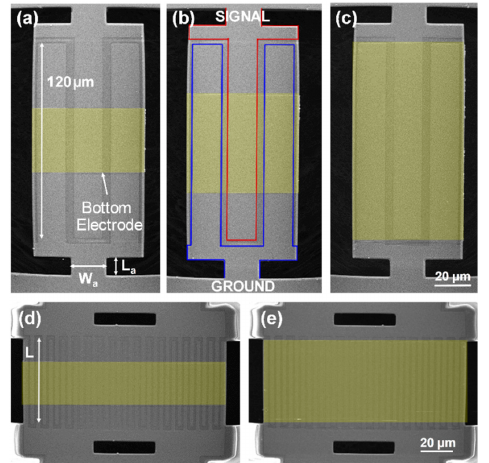
Figure 2. Scanning electron microscope (SEM) micrographs of the released AlN CMRs. ( a – c ) 230 MHz CMRs with bottom electrode coverage rates of 33%, 50%, and 100% (highlighted in yellow). ( d – e ) 1.1 CMRs with 50% and 100% bottom electrode coverage rates.